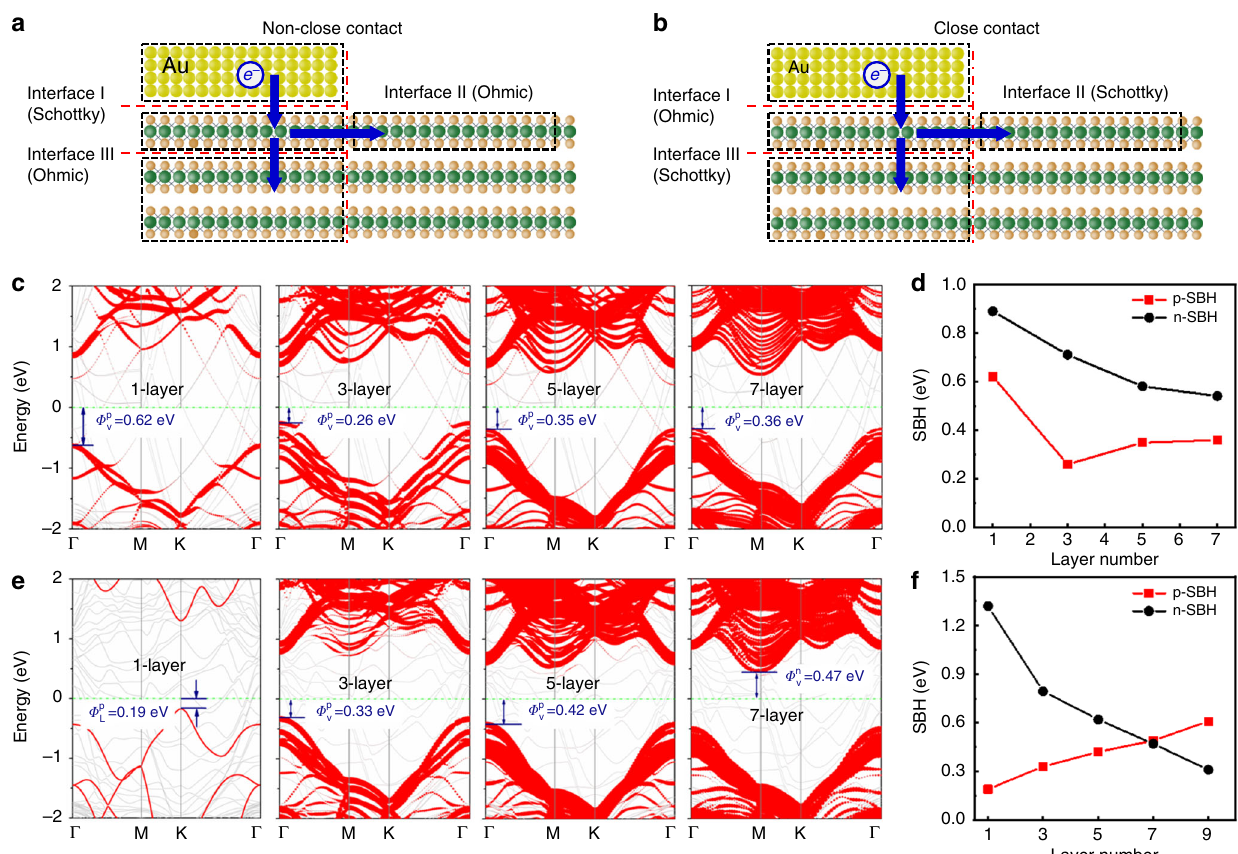
Fig. 3 DFT calculation of Au/WSe 2 interface with different contact approaches. a , b Schematic cross-sectional view of the Au/WSe 2 non-close-contact model ( a ) and the close-contact model ( b ). c Calculated band structures of WSe 2 with different thickness (under Au contact) for the non-close-contact model. The red dots denote the projected band structures of WSe 2 underlying the Au electrode, and the dots size represents the weights. d Variation of calculated SBH with WSe 2 layer number for the non-close-contact model, where dominated p-type SBH is always observed. e Calculated band structures of different thickness of WSe 2 under Au for the close-contact model. The red dots denote the projected band structures of WSe 2 underlying the fi rst layer WSe 2 , and the dot size represents the weights. f Variation of calculated SBH with WSe 2 layer number for the close-contact model, with a clear transition from p- to n-type SBH with increasing layer